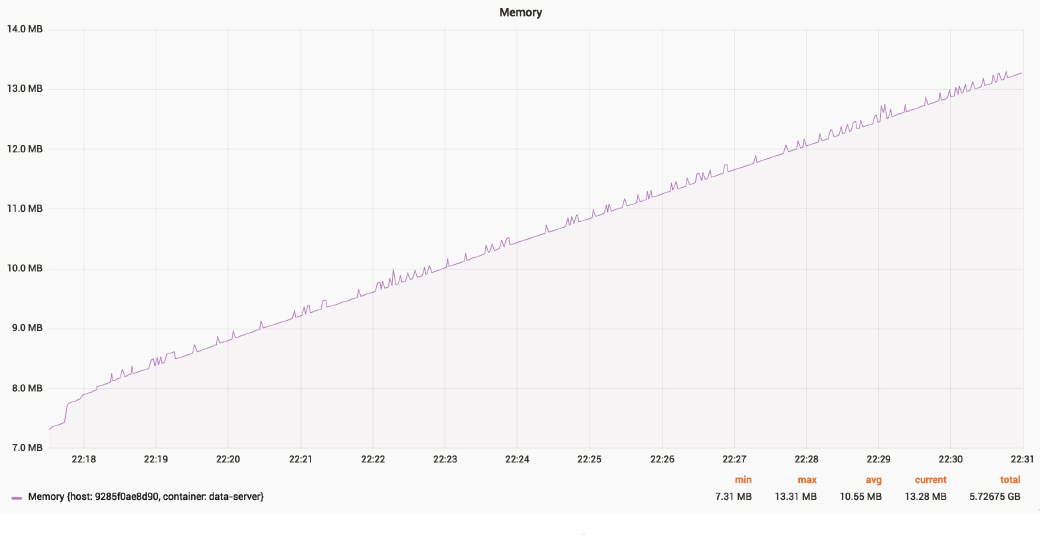
Figure 27. RAM usage for a